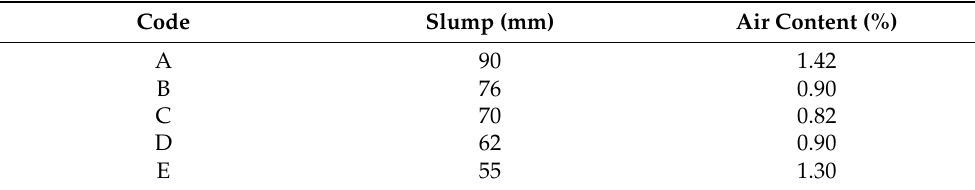
Table 5. Working performance of fresh concrete.